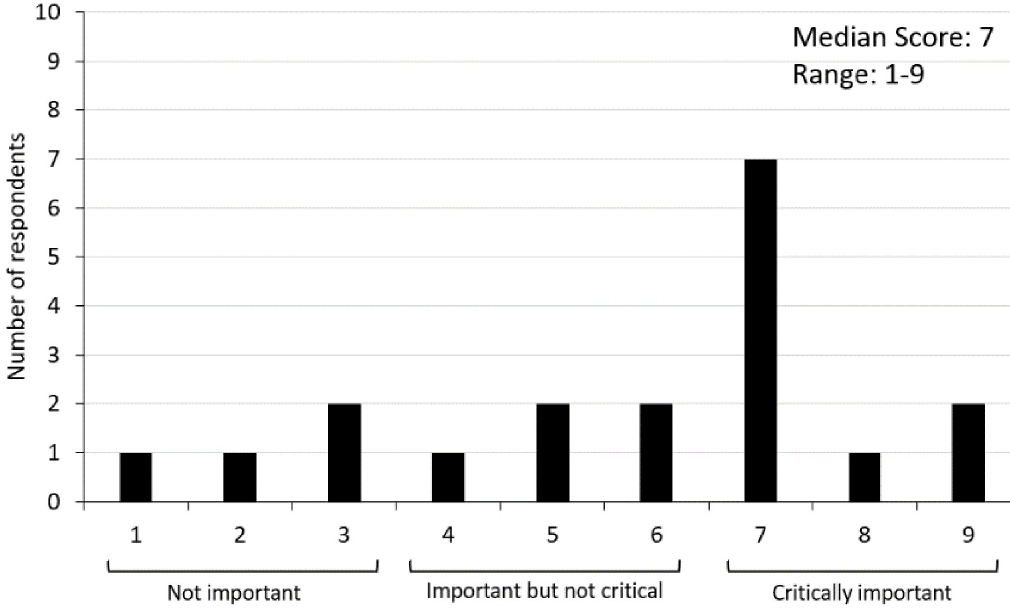
Fig 2. Example of group-level feedback on ratings of one evidence statement capturing the importance of supermarket tours as an intervention component.